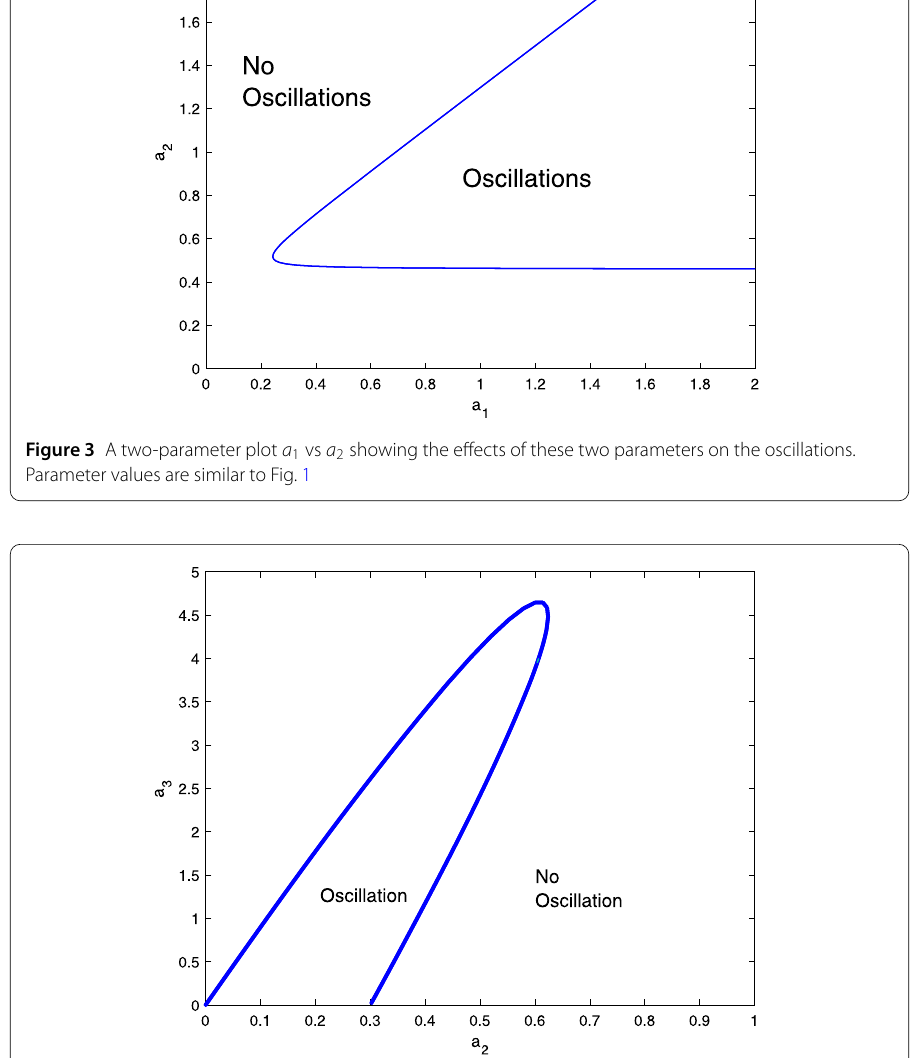
Figure 4 A two-parameter plot a 2 vs a 3 showing the effects of these two parameters on the oscillations. Parameter values are similar to Fig.